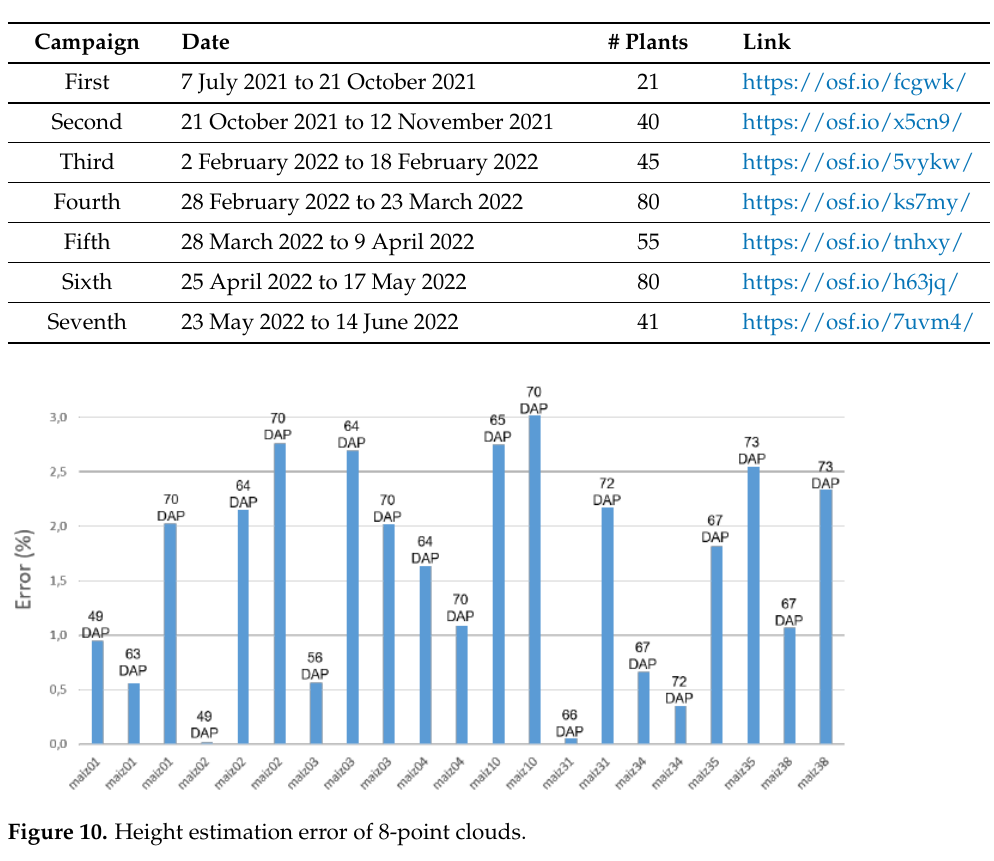
Table 3. Point clouds of maize plants separated by campaigns with their respective acquisition dates and number of scanned data.